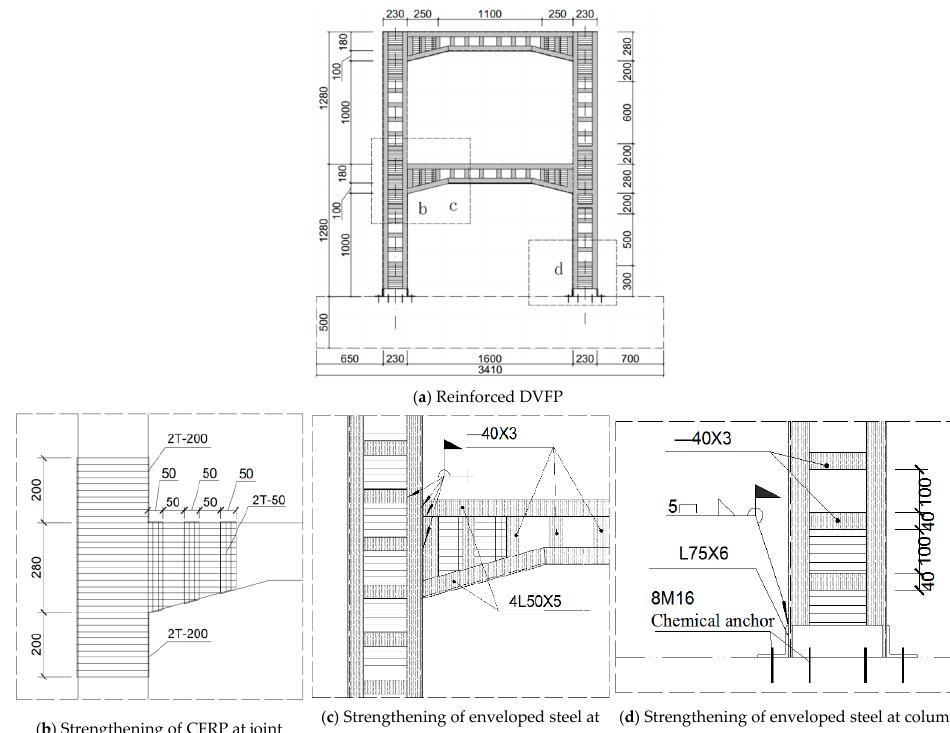
Figure 5. Reinforcement design of specimens. Figure 5.